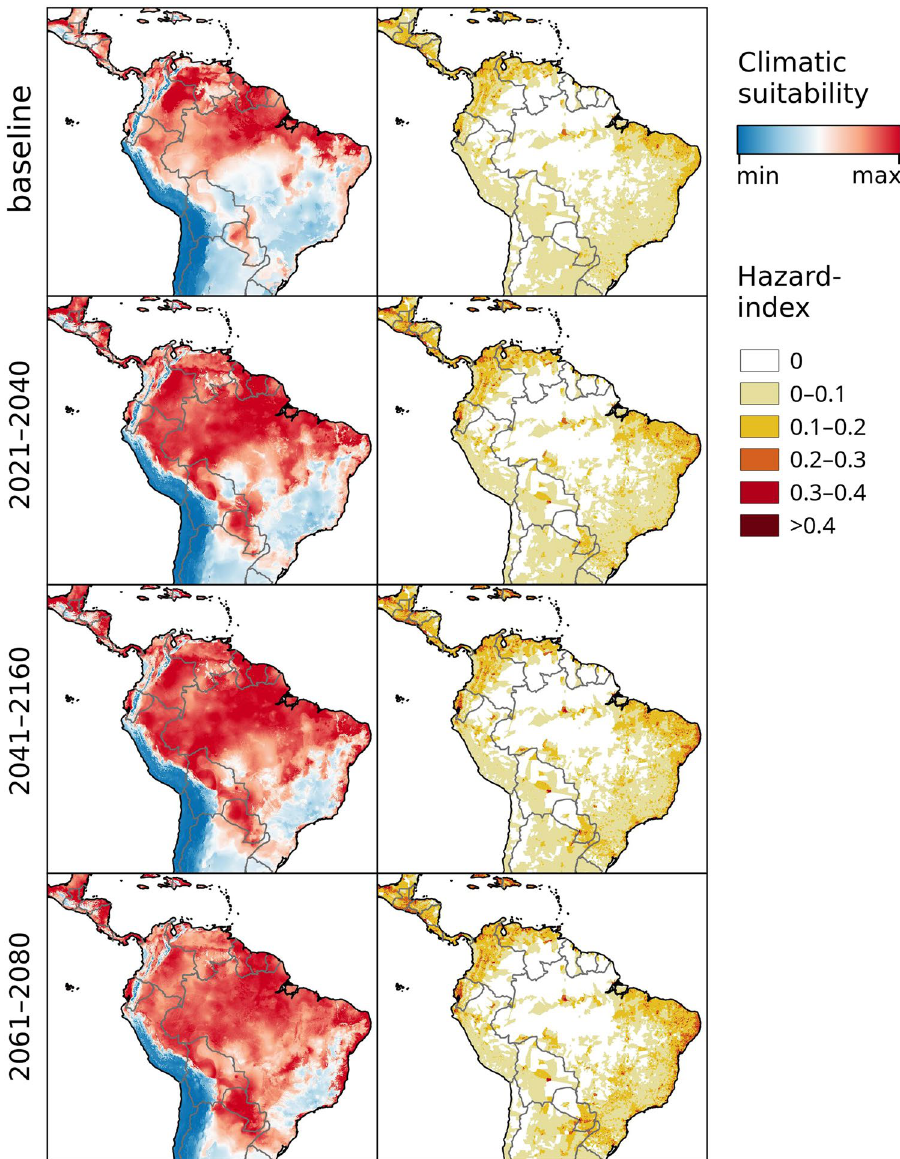
Figure 4. Chikungunya under the baseline and RCP 8.5 climate change scenarios in South America. Left: Climatic suitability, right: hazard index. Climate change scenarios represent the mean model output obtained through the 5 GCMs. Climatic suitability output is scaled to the over-all global minimum (0) and maximum (0.623) values observed in any model. Maps were generated using the “raster” package in R 3.3.2 (https://www.r- project.org/) and QGIS 2.8.1